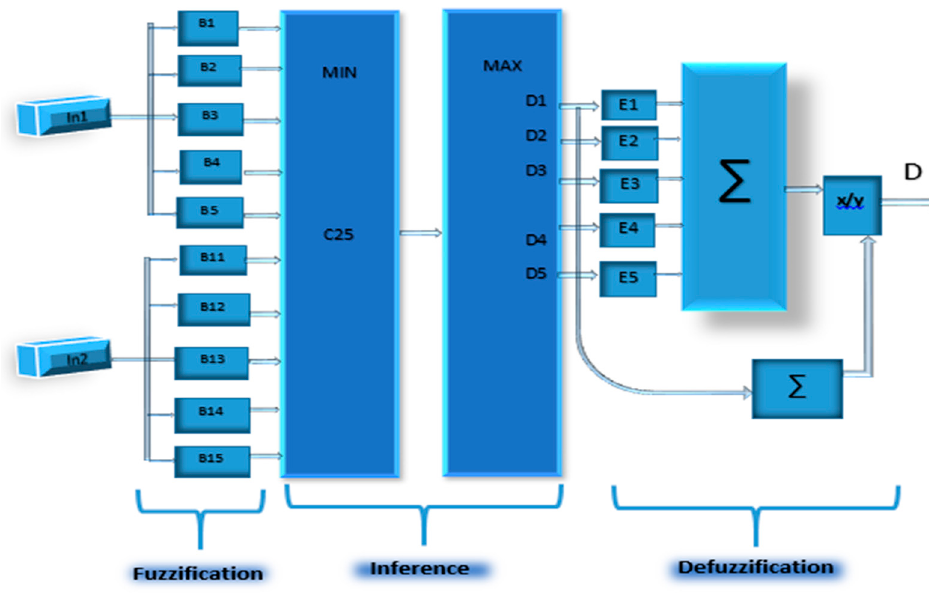
Figure 9. The functional diagram of the proposed control.